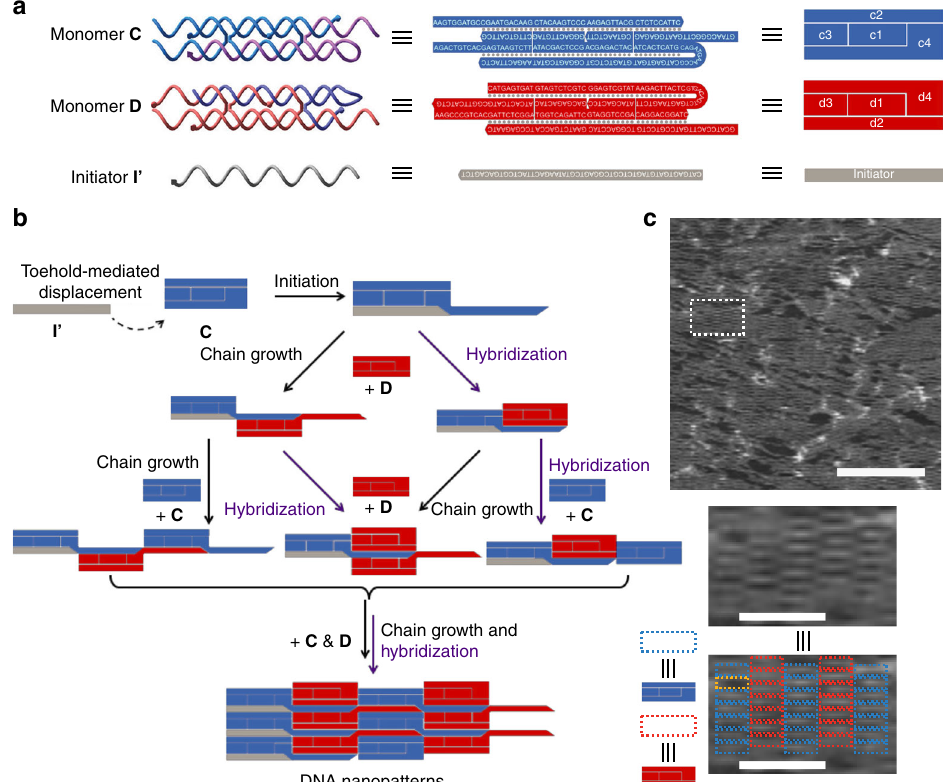
Fig. 4 Programmable 2D chain-growth copolymerization of DHT nanoplatelets. a Schematics of structures (left), sequences (middle), and simpli fi ed cartoons of two monomers C (blue) and D (pink) and initiator strand ( I ’ ). b 2D chain-growth supramolecular copolymerization of monomers C and D initiated with I ’ . Copolymerization starts with the strand displacement reaction of initiator I ’ with monomer c3 , exposing the loop sequence of c4 to further invade the hairpin domain of D and open the d3 . The opened d3 contains an identical toehold to I ’ , which can further activate the monomer C . Meanwhile, supramolecules are assembled with the associations of monomers ’ corner sticky ends in a direction perpendicular to the helical axis. c Atomic force microscopy (AFM) images of 2D DHT nanoplatelets. Scale bars: 200 nm. (Inset) Zoomed-in AFM image. Dashed line squares indicate monomers C (blue) and D (red). Scale bars: 50